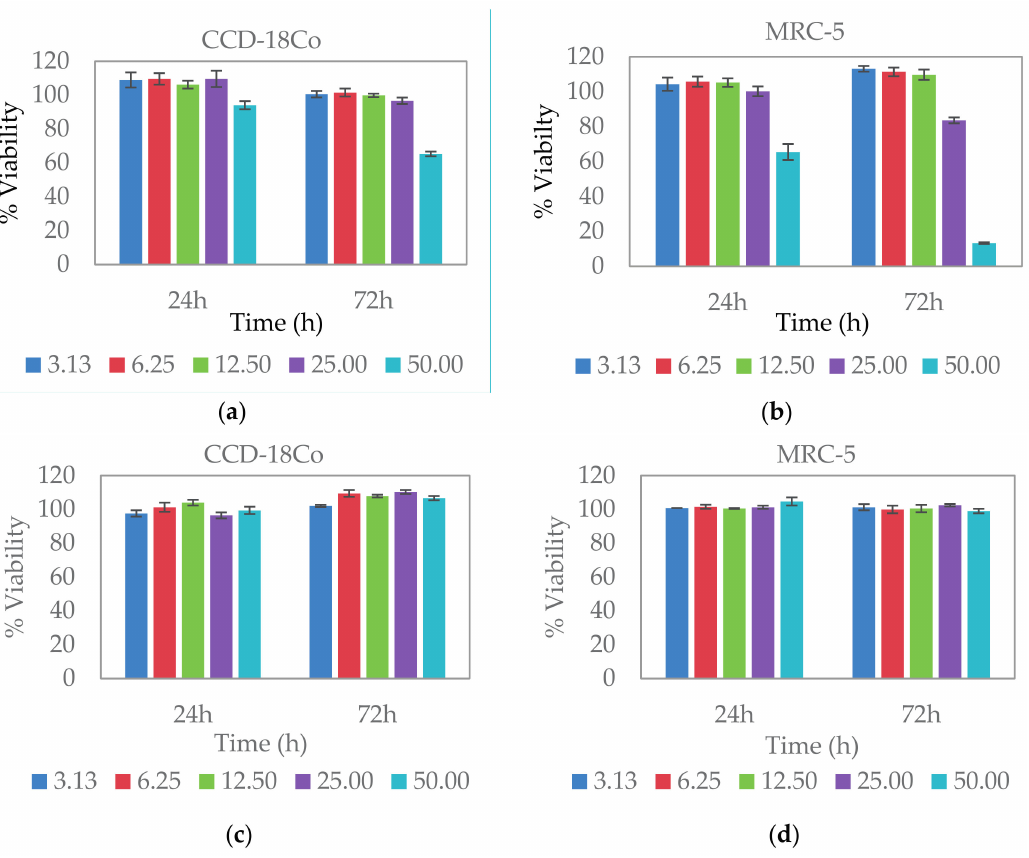
Figure 5. The percentage of viability by the SRB assay for ( a ) human colon fibroblast cell (CCD-18Co) and ( b ) human lung fibroblast cell (MRC-5) after exposure to AuNPs for 24 and 72 h in a dose-dependent manner. The percentage of viability of ( c ) CCD-18Co and ( d ) MRC-5 upon treatment with CM extract for 24 and 72 h. Concentrations of AuNPs and CM extract used in the experiments were 3.13, 6.25, 12.50, 25.00, and 50.00 µ g/mL. Results are shown as mean ± S.E. with n =